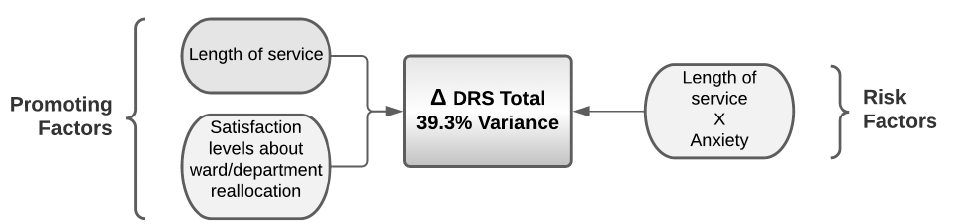
Figure 4. Promoting and risk factors for the variance in the hardiness assessed by DRS total resulting from the logistic regression.